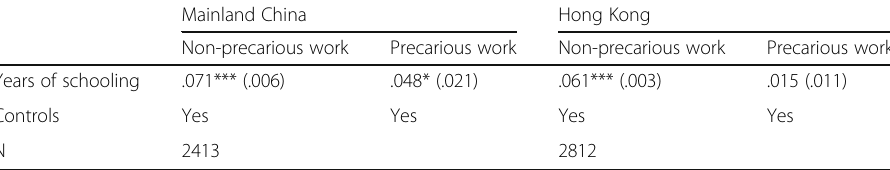
Table 5 Differential in return on education between precarious workers and non-precarious workers in mainland China and Hong Kong (switching regression) Mainland China Hong